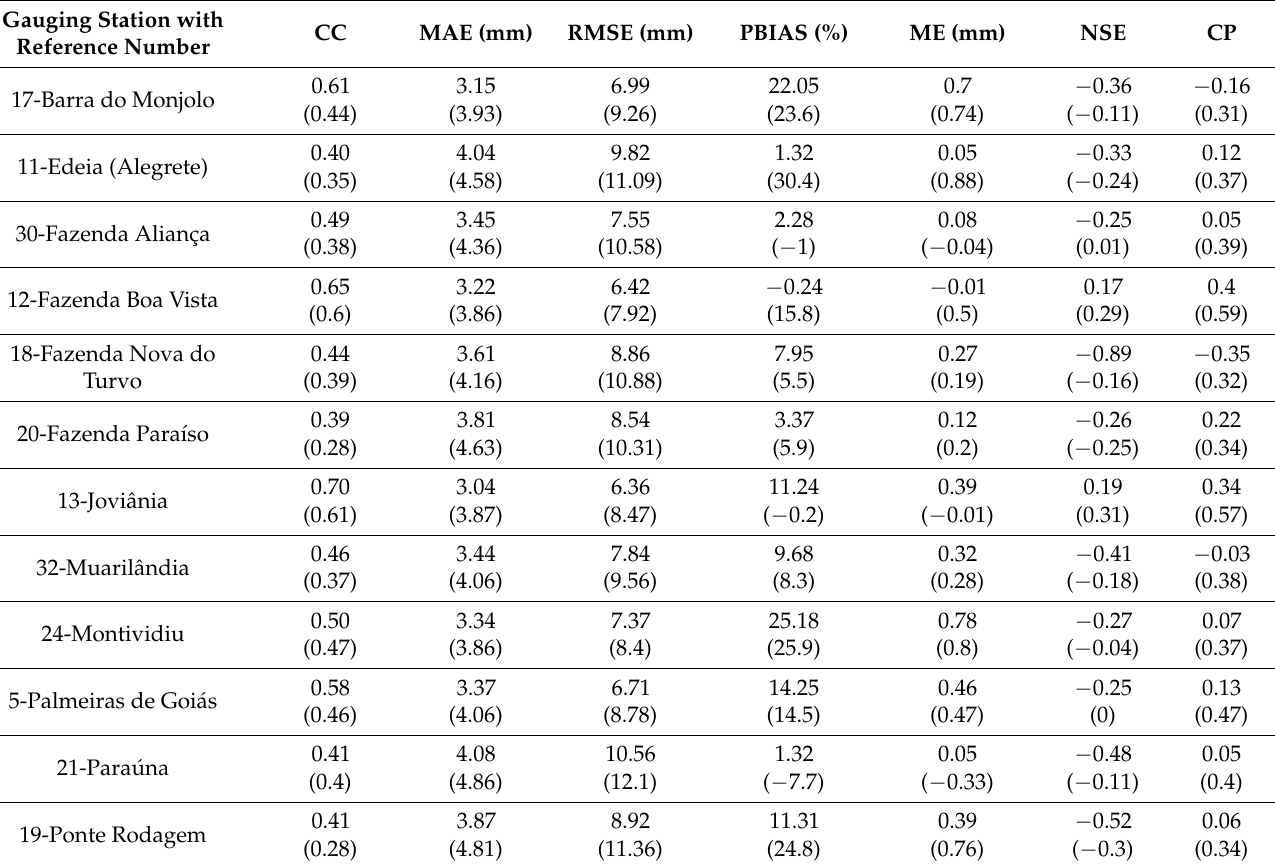
Table 4. Goodness-of-fit metrics for interpolated and raw (in parentheses) daily precipitation data from 12 gauging stations located in the Bois River